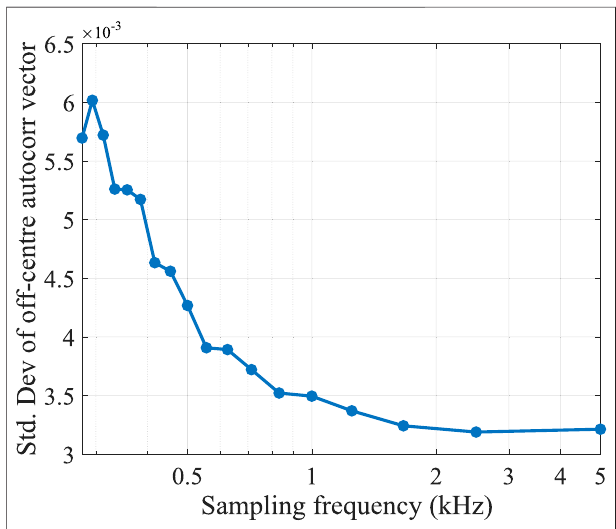
FIGURE9| Thestandarddeviationoftheoff-centrevaluesareshownas an inverse measure of randomness; the randomness asymptotically improves with increasing sampling